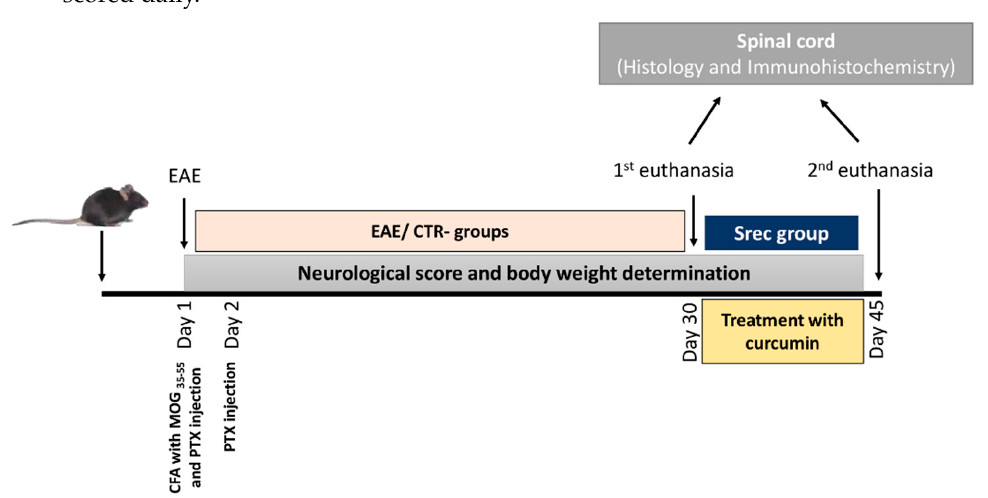
Figure 9. Schematic description of demyelination experimental design.